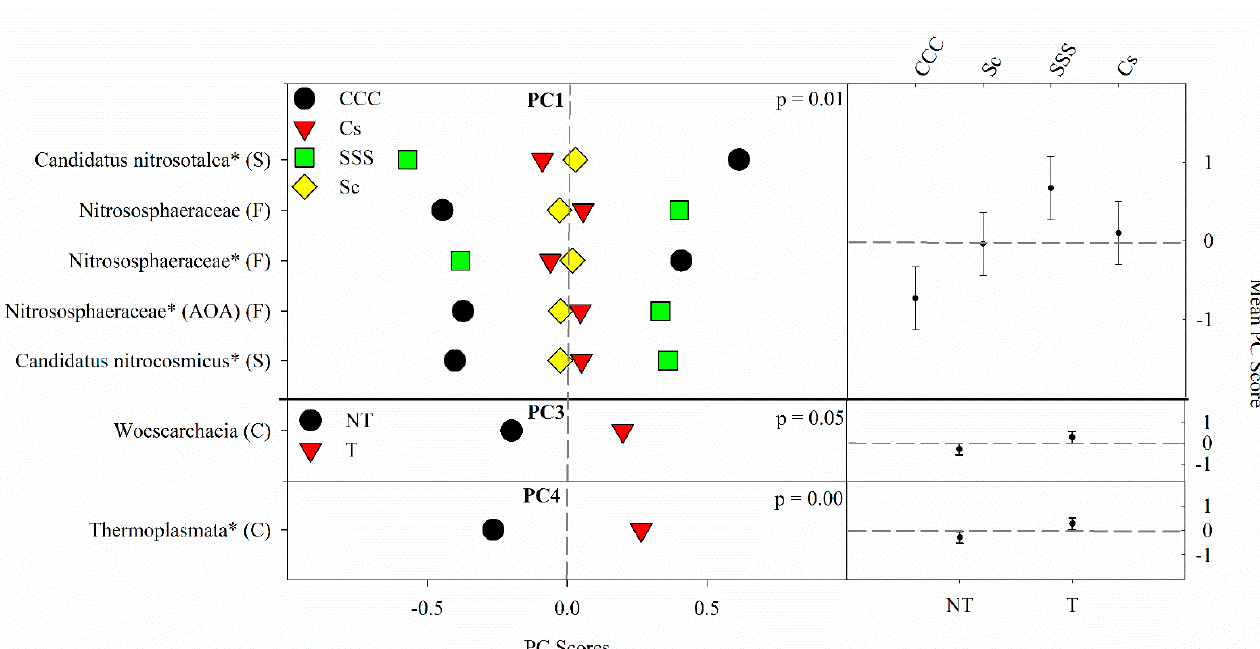
Figure 4. Mean archaeal principal component scores (PC) following 20 years of rotation and tillage treatments. Right panels show the archaeal mean PC score for the main effects of crop rotation for PC1 and tillage for PC3 and PC4 based on the analysis of variance (ANOVA); error bars represent standard errors of the mean PC scores. Left panels show relative abundances (RAs) for each archaeal indicator ASVs by crop rotation and tillage. The crop rotation main effects for PC1 are shown as CCC, continuous corn; Cs, corn phase of the corn-soybean rotation; Sc, soybean phase of the corn-soybean rotation; SSS, continuous soybean. The tillage effects for PC3 and PC4 are shown as NT, no-till; T, chisel tillage. For each taxon, the response of each ASV was calculated as the mean PC score multiplied by the PC loading score of a given ASV. The y-axes show the name of the ASV’s most explanatory taxonomic rank in parentheses (P, phylum; C, class; O, order; F, family; G, genus; S, species). The “*” after an ASV means it is uncultured. AOA denotes ammonia-oxidizing archaea.